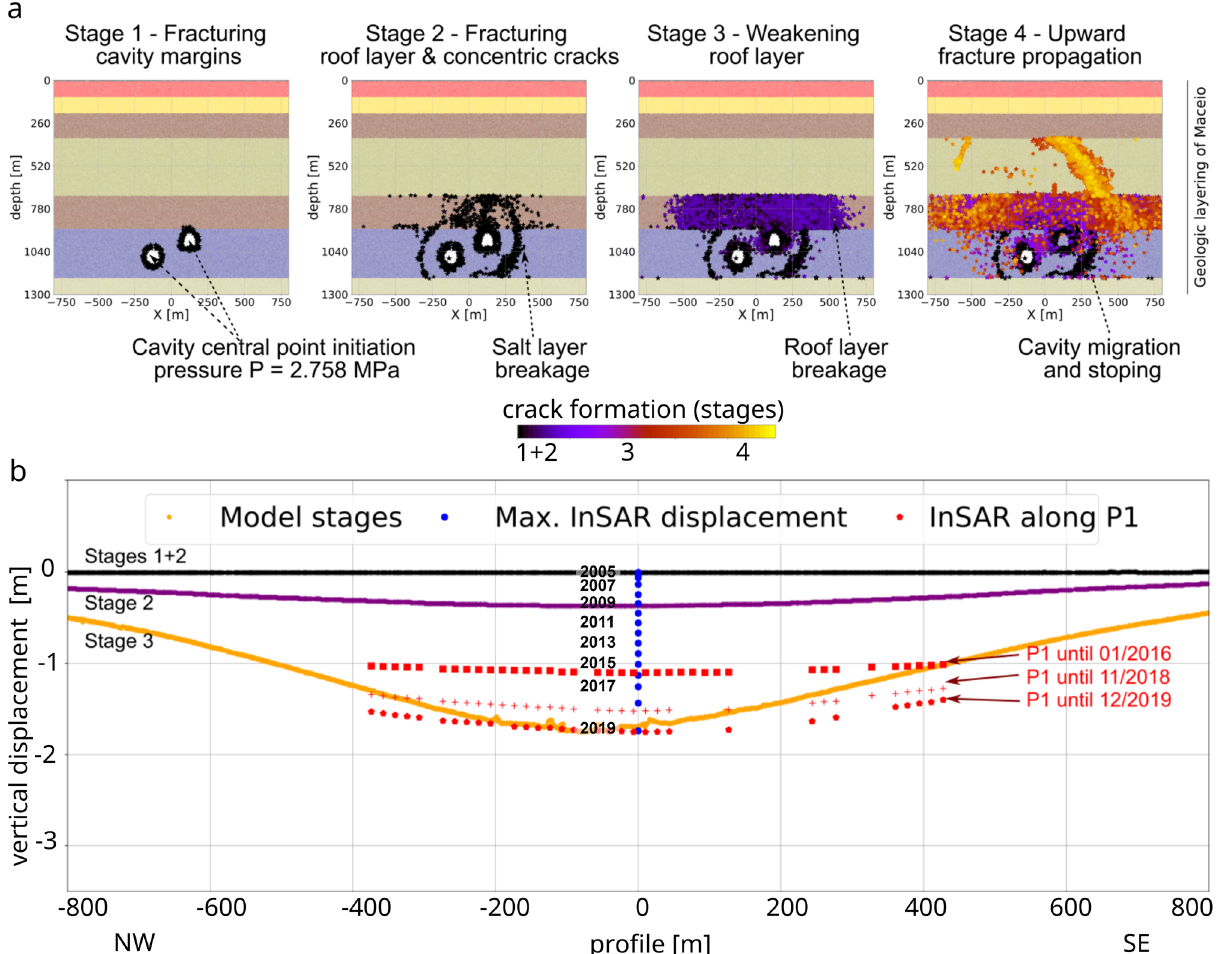
Figure 4. Simulated DEM subsidence models for pressurized cavity scenario (S1, P = 2.758 MPa). ( a ) Crack and fracture evolution representation of the four stages of cavity collapse shown in black–purple–yellow colour scale; the stratified background represents the geological layering model (see “Data and methods”). ( b ) Induced surface deformations for the four stages (black–purple–yellow colour scale) compared to InSAR surface subsidence results along the profile P1 (Fig. 3a). The figures were plotted using Matplotlib python library using data from simulations and InSAR time series data along profile